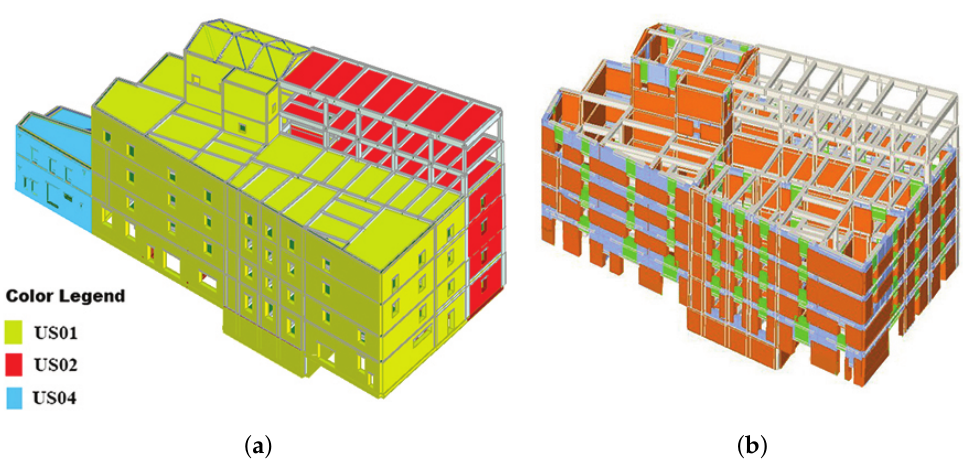
Figure 14. Structural model performed using the “macro-elements” modeling